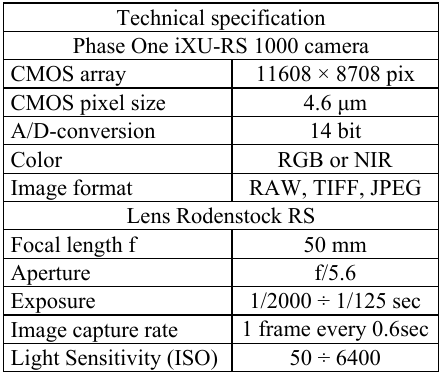
Table 1. Phase One iXU-RS 1000 camera parameters